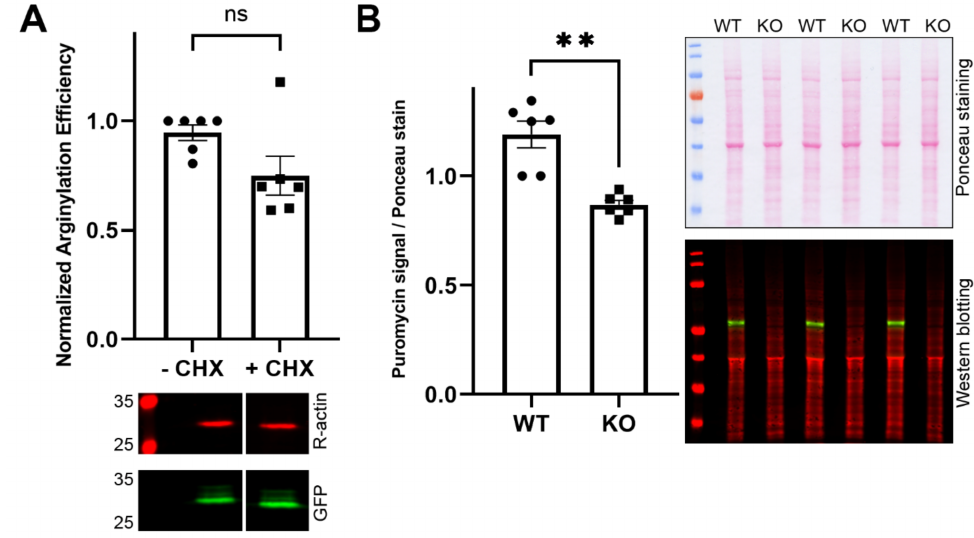
Figure 2. Intracellular arginylation depends on the physiological state of the cell but does not compete with active translation. ( A ) Chart (top) and representative immunoblots (bottom) of arginylation sensor quantification in human embryonic kidney 293T cells with and without the addition of cycloheximide (CHX) and chloramphenicol. Error bars represent SEM; n = 6. ns, not significant, Welch’s t -test. ( B ) Chart (left) and immunoblots (right) of wild-type (WT) and Ate1 knockout (KO) mouse embryonic fibroblasts stained with Ponceau S for total protein load (top), and puromycin (red) and ATE1 antibodies (green) (bottom). Ratios of total puromycin signal from the entire lane to the Ponceau S signal in the same lane normalized to the control were plotted. Error bars represent SEM; n = 6 biological replicates. ** p < 0.01, Welch’s t